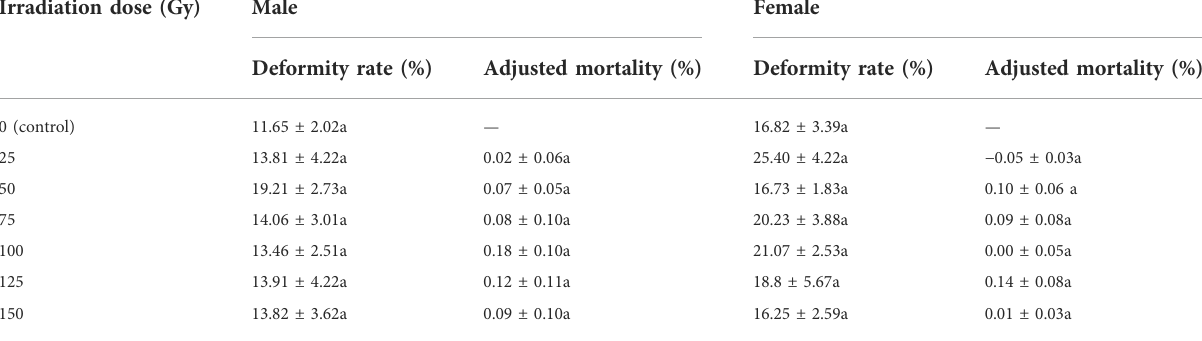
TABLE 1 Mean (±SE) deformity rates and adjusted mortality of pupae of Spodoptera litura after irradiation with different doses of X-rays. Irradiation dose